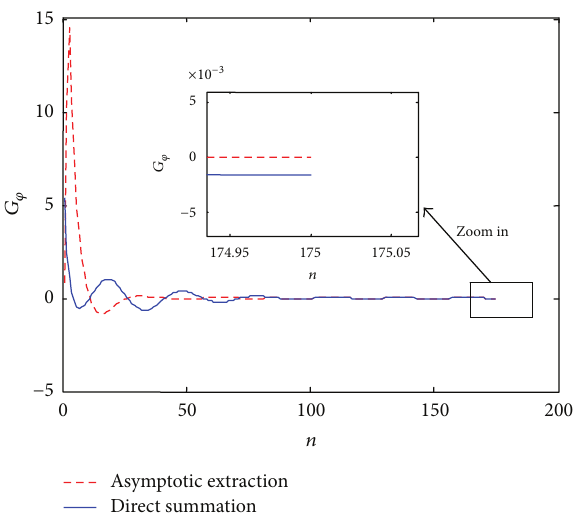
Figure 9: Convergence of 𝐺 22 𝜑 when source and field points are located in the same triangle at the probe.